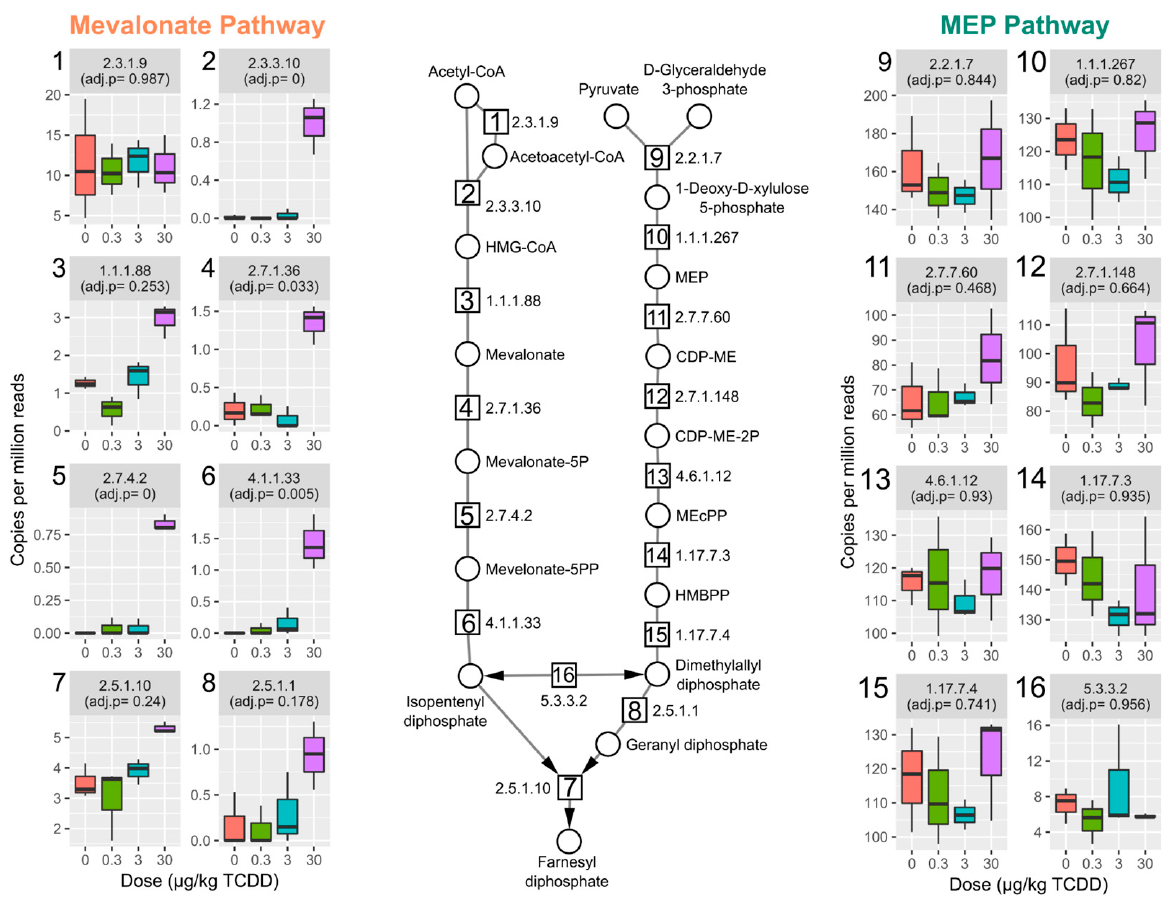
Figure 3. TCDD enriched genes from the mevalonate-dependent isoprenoid biosynthesis pathway. Relative abundance of genes involved in isoprenoid biosynthesis and grouped by enzyme commission (EC) numbers for the mevalonate dependent and 2-C-methyl-D-erythritol 4-phosphate (MEP) pathways in cecum samples from male C57BL6 mice following oral gavage with sesame oil vehicle or 0.3, 3, or 30 µ g/kg TCDD every 4 days for 28 days ( n = 3). Individual box plots are also numbered with the EC number matching the enzymatic step in pathway schematic. Adjusted p -values (adj. p ) were determined by the Maaslin2 R package. Abbreviations: 3-hydroxyl-3-methyl-clutaryl-CoA (HMG-CoA), (R)-5-Phosphomevalonate (mevalonate-5P), (R)-5-Diphosphomevalonate (mevalonate-5PP), 2-C-Methyl-D-erythritol 4-phosphate (MEP), 4-(Cytidine 5 (cid:48) -diphospho)-2-C-methyl-D-erythritol (CDP-ME), 4-(Cytidine 5 (cid:48) -diphospho)-2-C-methyl-D-erythritol (DEP-ME-2P), 2-C- Methyl-D-erythritol 2,4-cyclodiphosphate (MEcPP), and 1-Hydroxy-2-methyl-2-butenyl 4-diphosphate